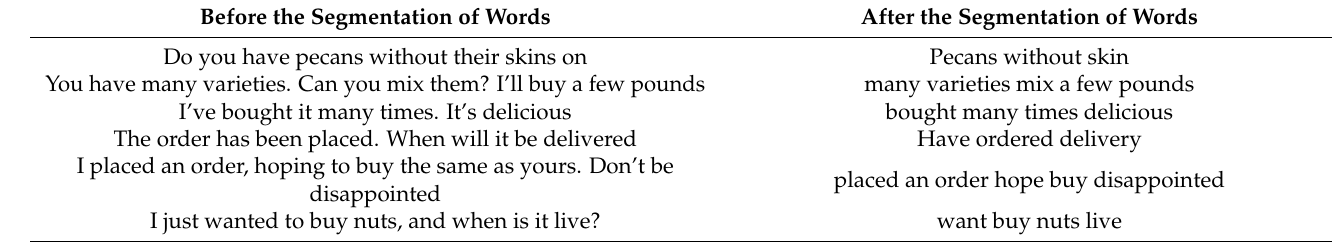
Table 1. Results of word segmentation.